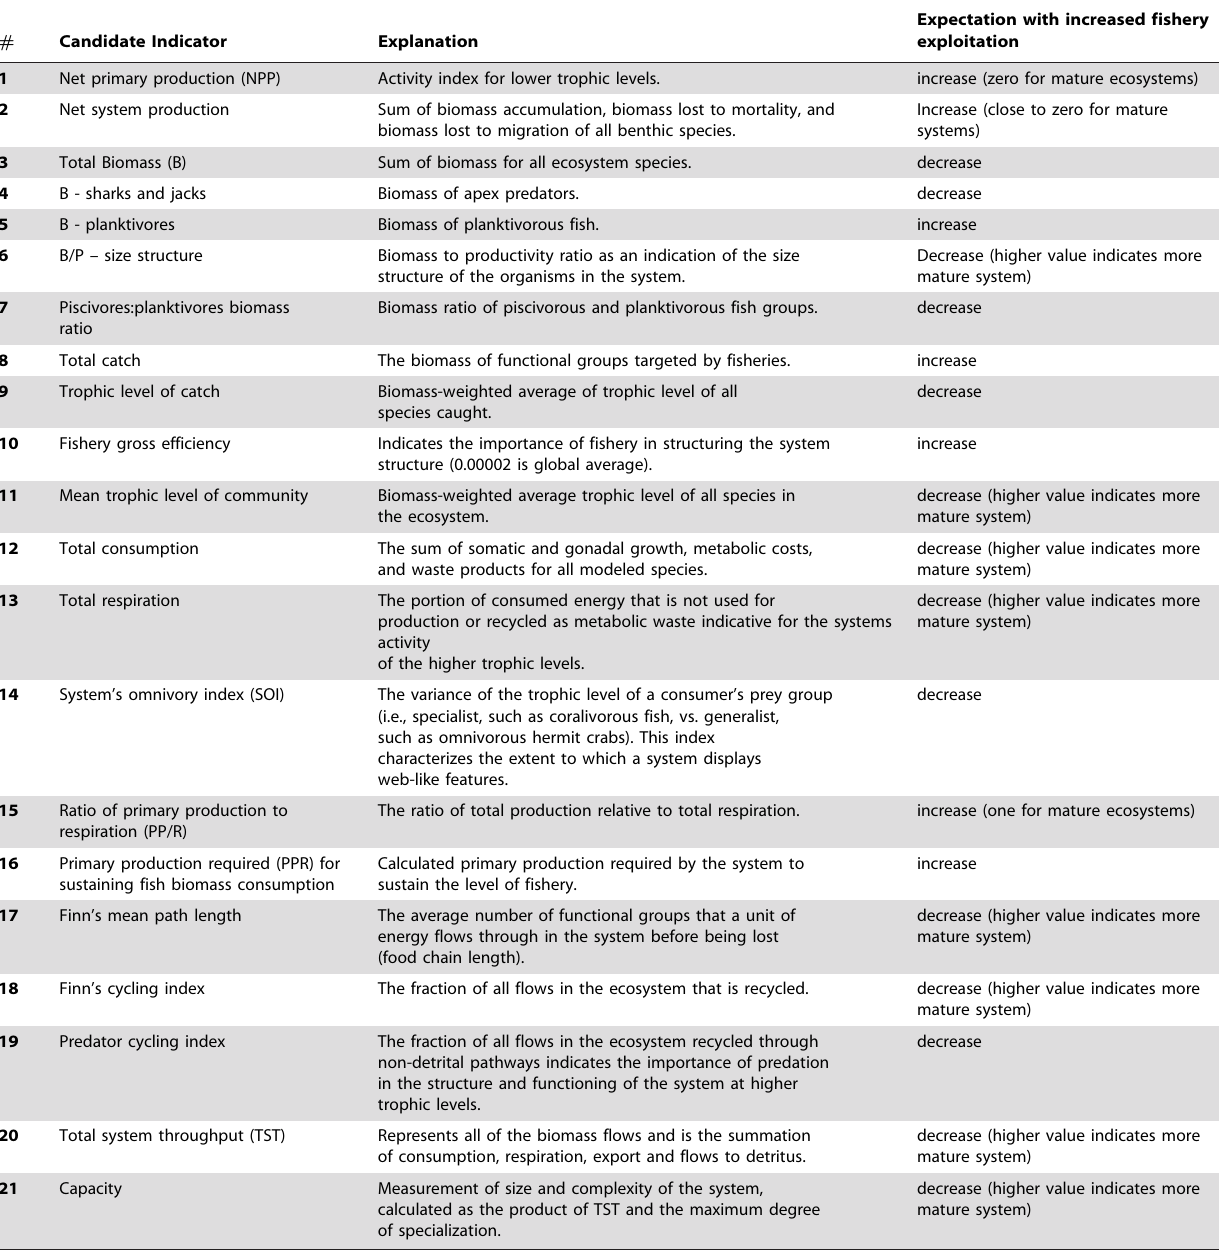
Table 2. Selected candidate indicators for coral reef ecosystem effects of